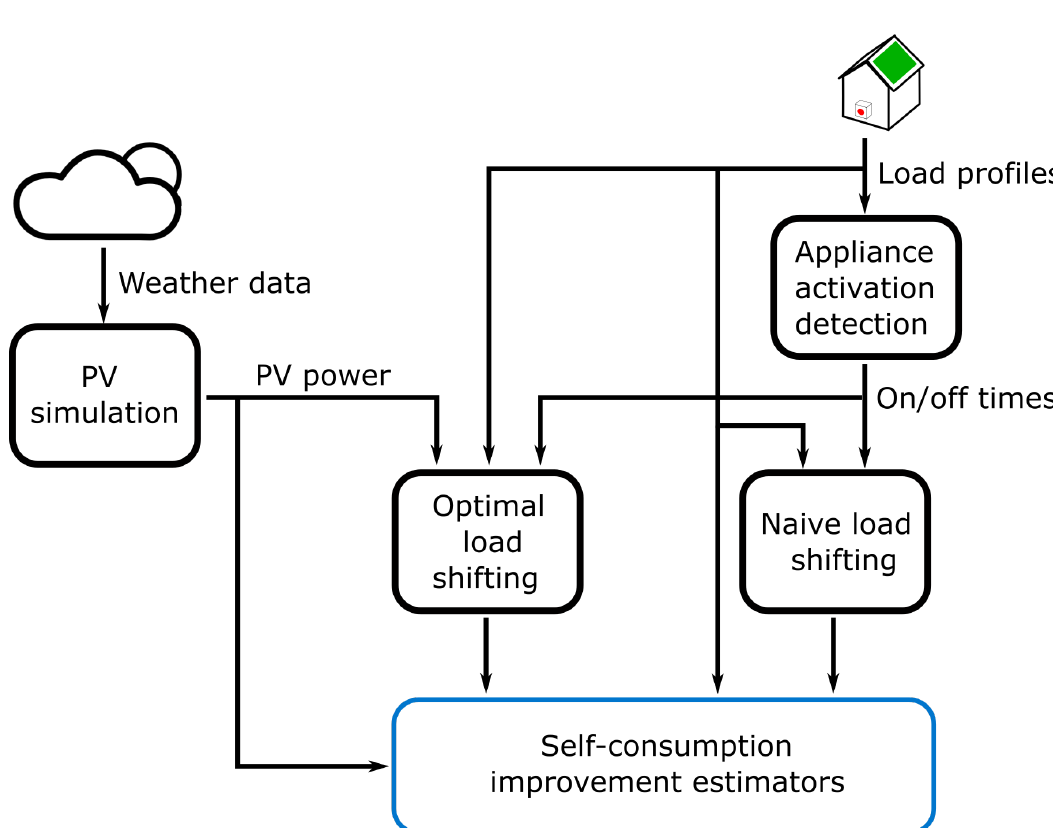
Figure 2. Illustration of the simulation workflow. The load and PV data define the baseline for self-consumption. Activations are extracted from load data and used to feed two load shifting algorithms. After load shifting, the improvement is